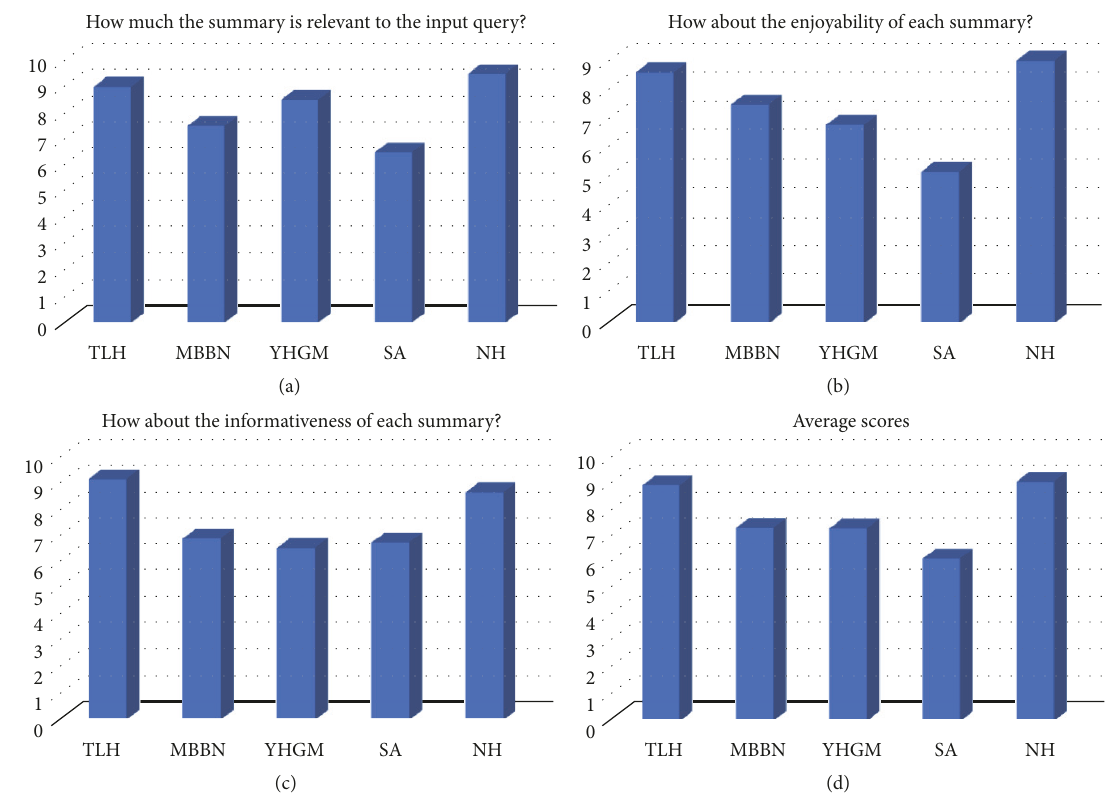
Figure 6: Subjective evaluation of the generated summaries: (a), (b), and (c) represent average scores for Q 1, Q 2, and Q 3, respectively, and (d) shows the average scores of all the three